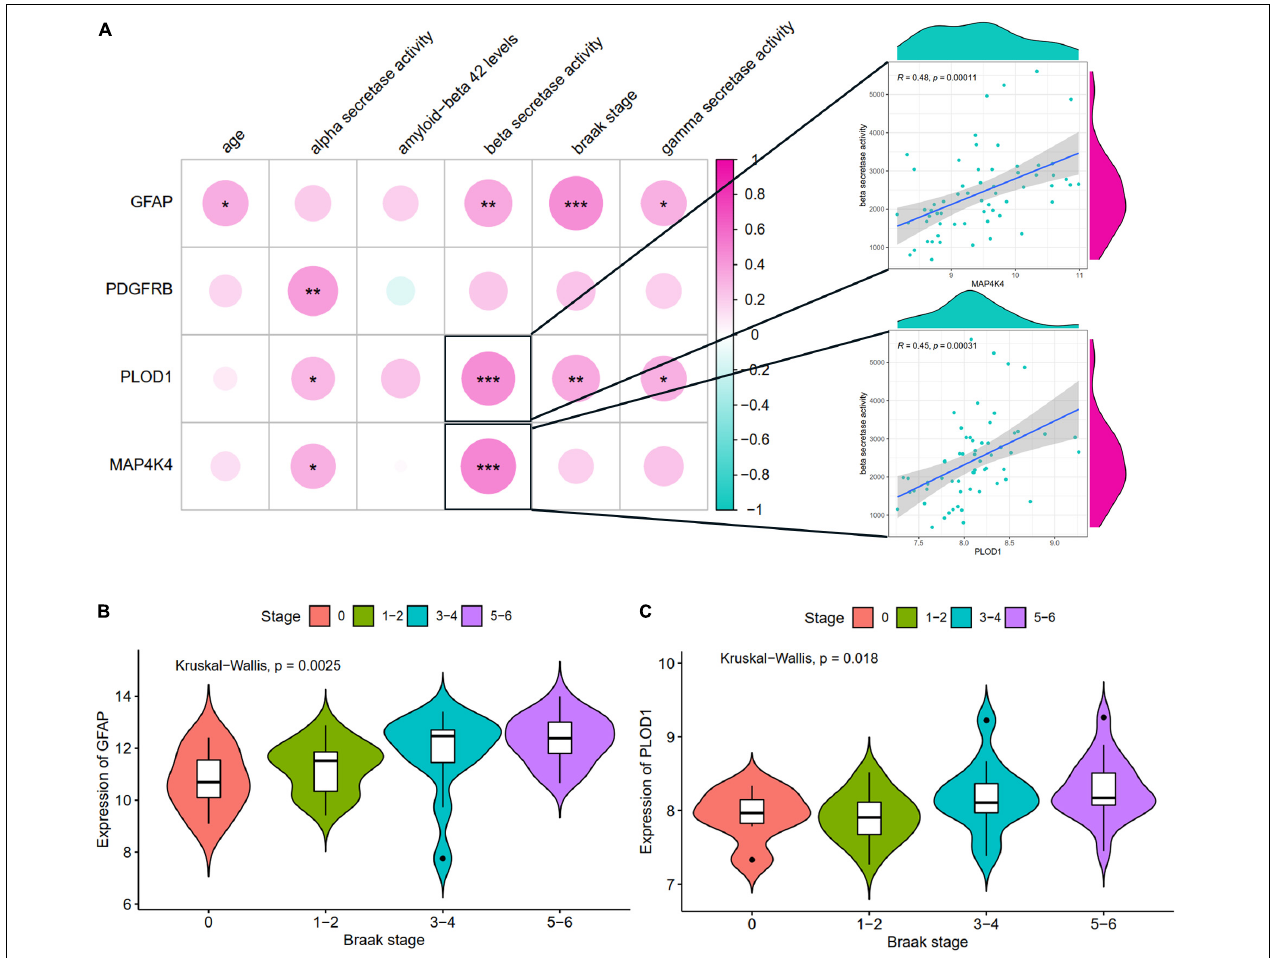
FIGURE 7 | The correlation between hub ARDEGs and clinical characteristics in GSE106241. (A) The landscapes of the correlation between hub ARDEGs and clinical characteristics. The two respective scatterplots show hub ARDEGs and clinical characteristics with the highest correlation; (B,C) Shows the expression levels of GFAP and PLOD1 in different Braak stages, respectively. Significance level was denoted by * p -value < 0.05, ** p -value < 0.01, *** p -value <